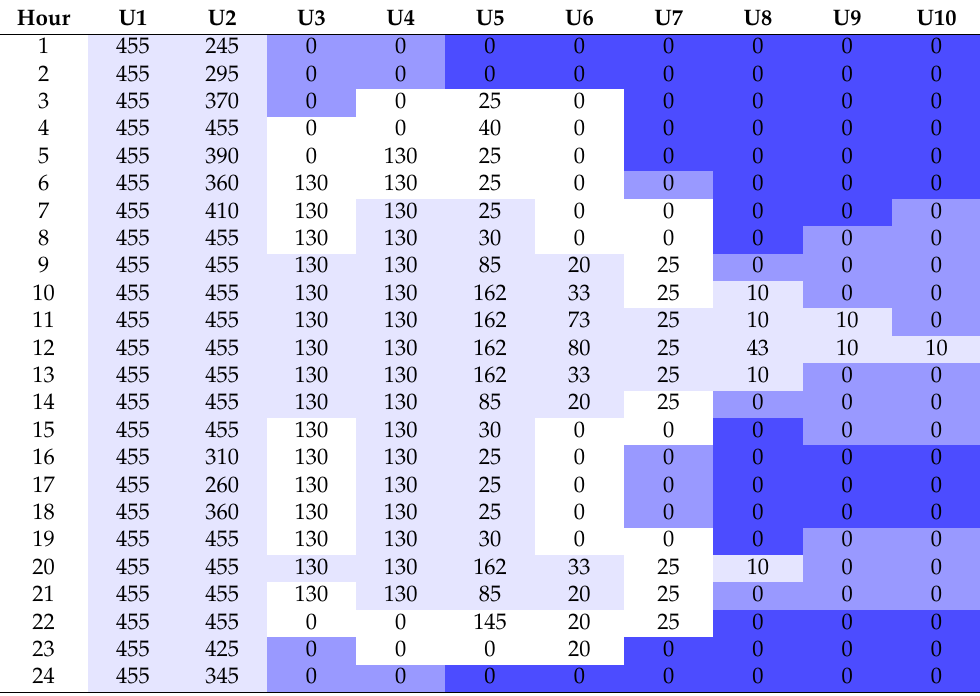
Table 9. Global optimal power schedule, in MW, of the system with 10 TGs, including relevance levels.